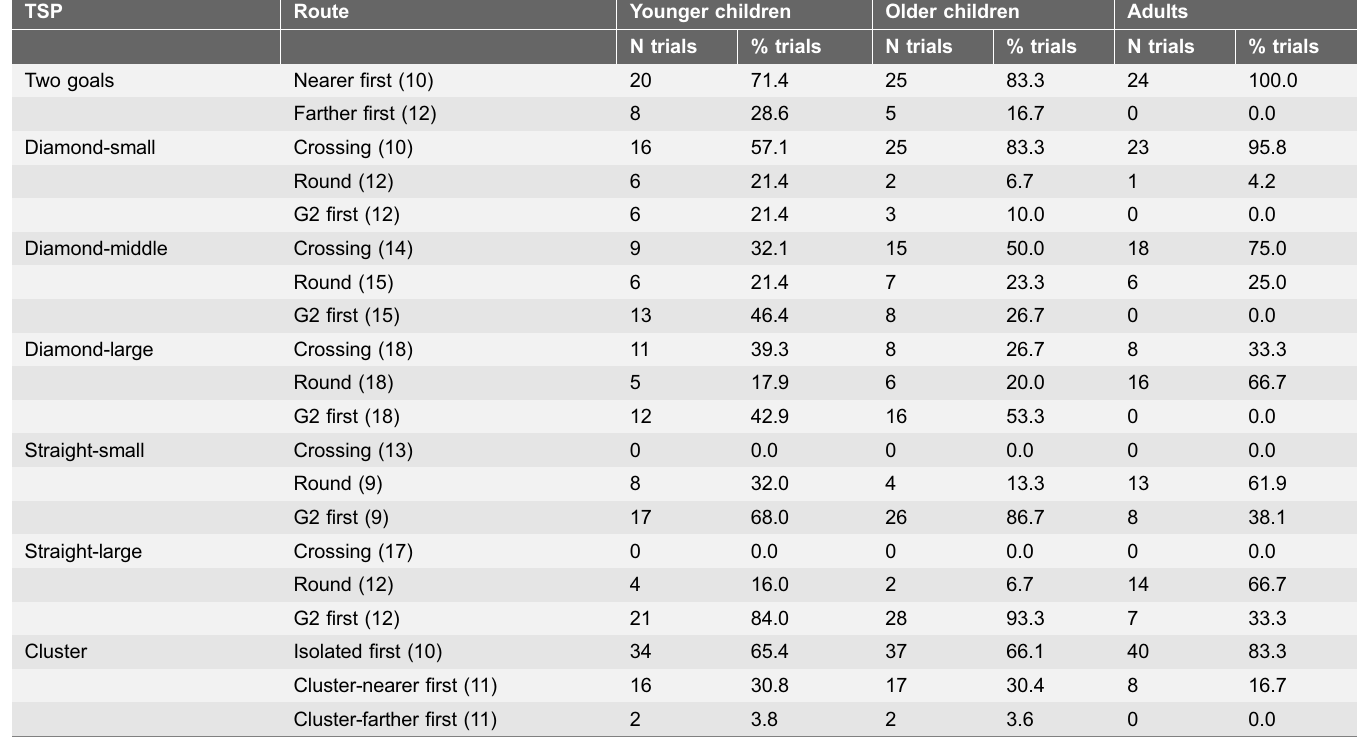
Table 3. Number and proportion of trials with selection of each route. TSP